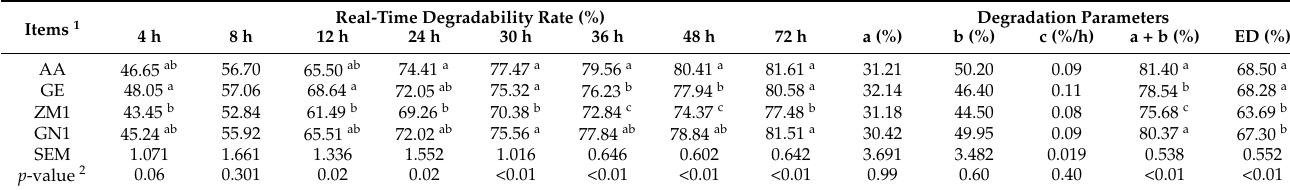
Table 4. Rumen degradable characteristics of CP from various alfalfa hay cultivars %.